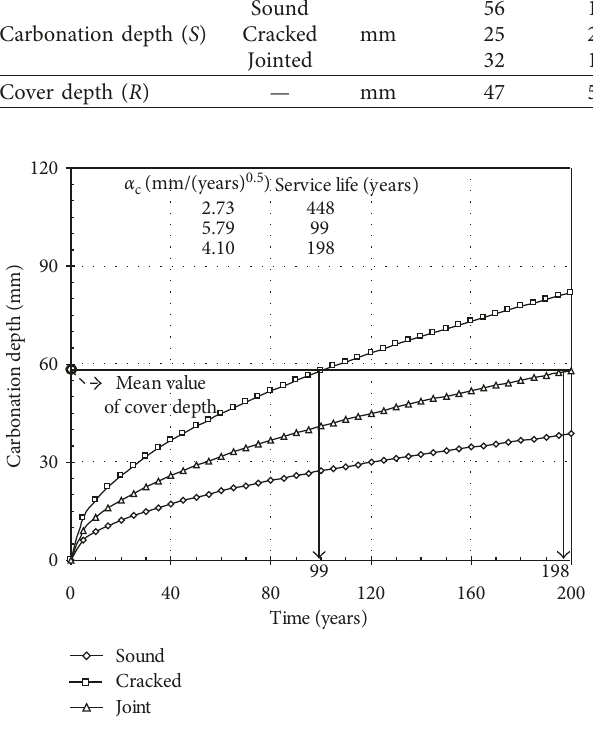
Figure 8: Unfactored carbonation depth over time for sound, cracked, and jointed concrete cover.